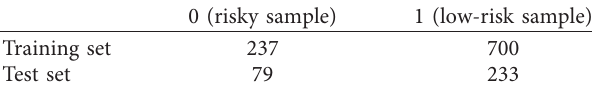
Table 6: Training set and test set sample